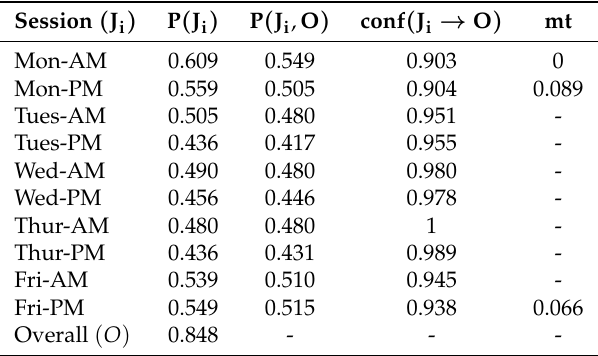
Table 3. Identifying target sessions—2016/2017. T t = 180.